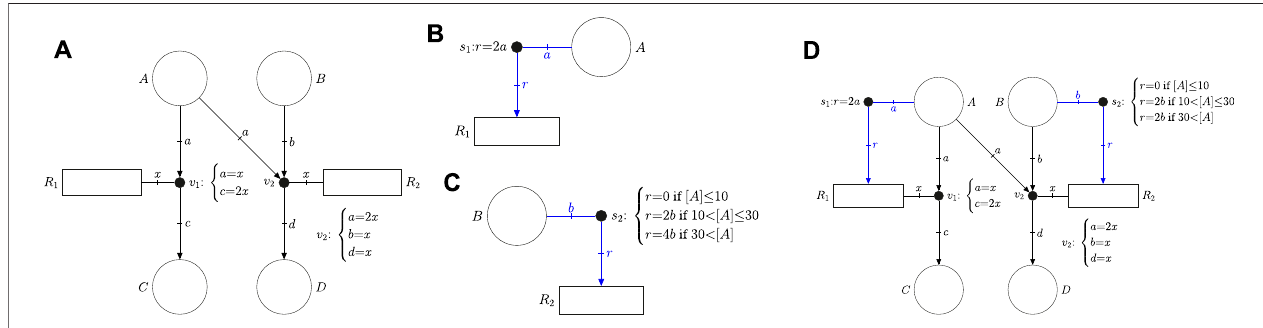
FIGURE 1 | (A) Event net modeling the stoichiometry of reactions R 1 : A → 2 C and R 2 2 A + B → D . (B ) Intensity net producing a speed in R 1 proportional to the concentration [ A ]. (C) Guarded intensity net producing a speed in R 2 equal to 0 if [ A ] is below 10, 2 [ B ] if [ A ] is between 10 and 30, and 4 [ B ] otherwise. (D) Flexible net combining the event net in (A) and the intensity nets in (B) and (C)